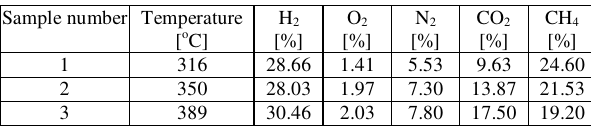
Table 6. Composition of synthesis gas obtained from glycerol at a concen- tration of 99.5% with the addition of 20% water